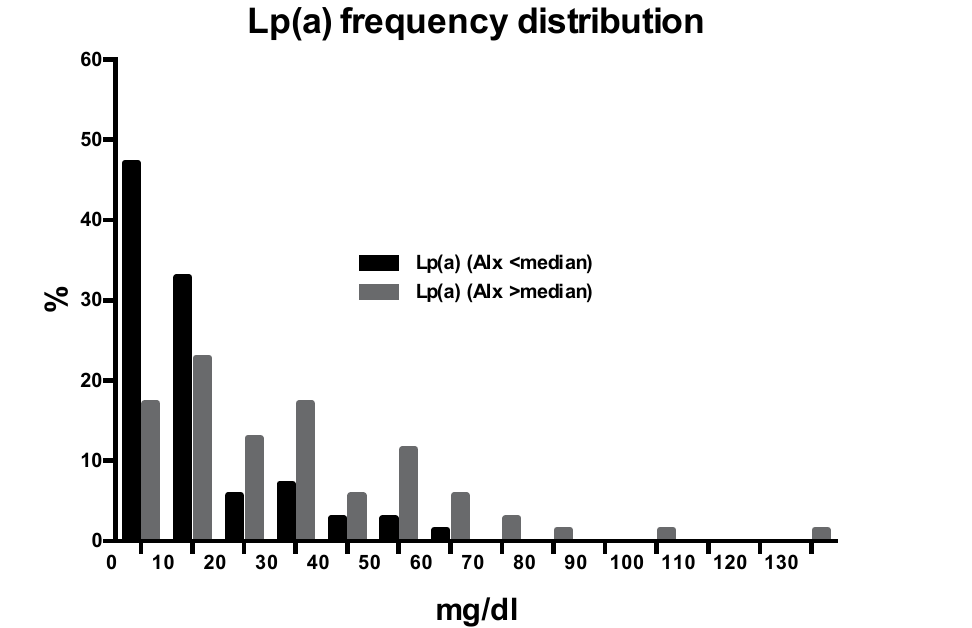
Figure 1. The frequency distribution of plasma Lp(a) levels in hypertensive patients with an augmentation index (AIx) above or below the median value.